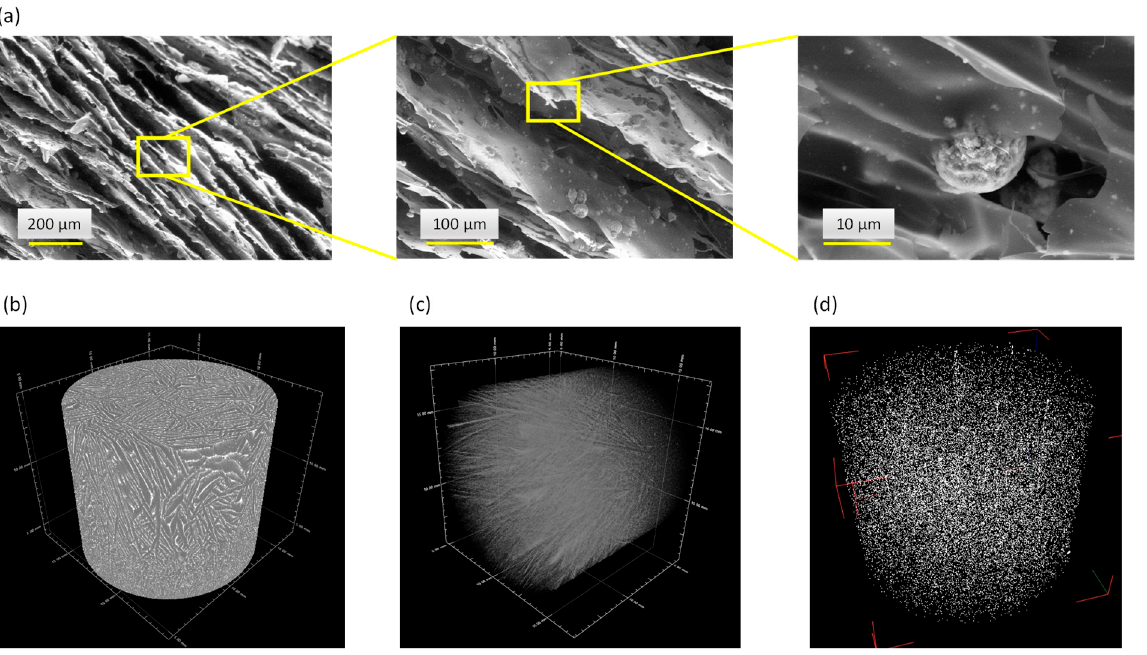
Figure 7. Freeze-cast 3D porous scaffolds associating alginate and core-shell particles: SEM micro- graphs ( a ) and μ CT image ( b ) of the alginate scaffold with embedded [(Cu 2+ )Ag + ] particles, ( c ) μ CT ROI reconstruction of the porous network and ( d ) spatial distribution of the [(Zn 2+ )Cu 2+ ] core-shell particles embedded in the alginate matrix.